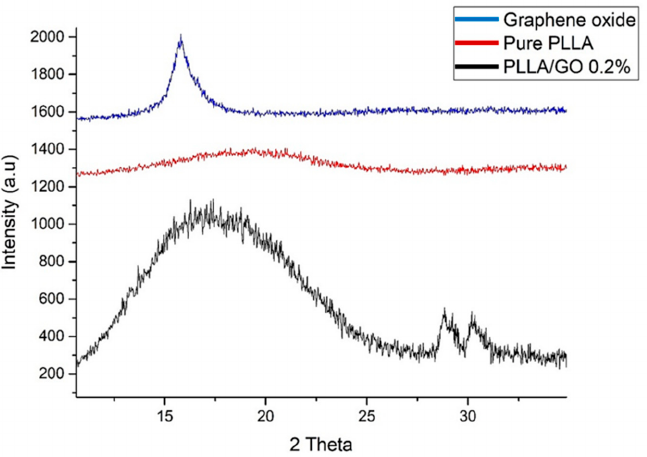
Figure 1. Pure PLLA, GO and processed biocomposite X-ray diffraction (XRD)